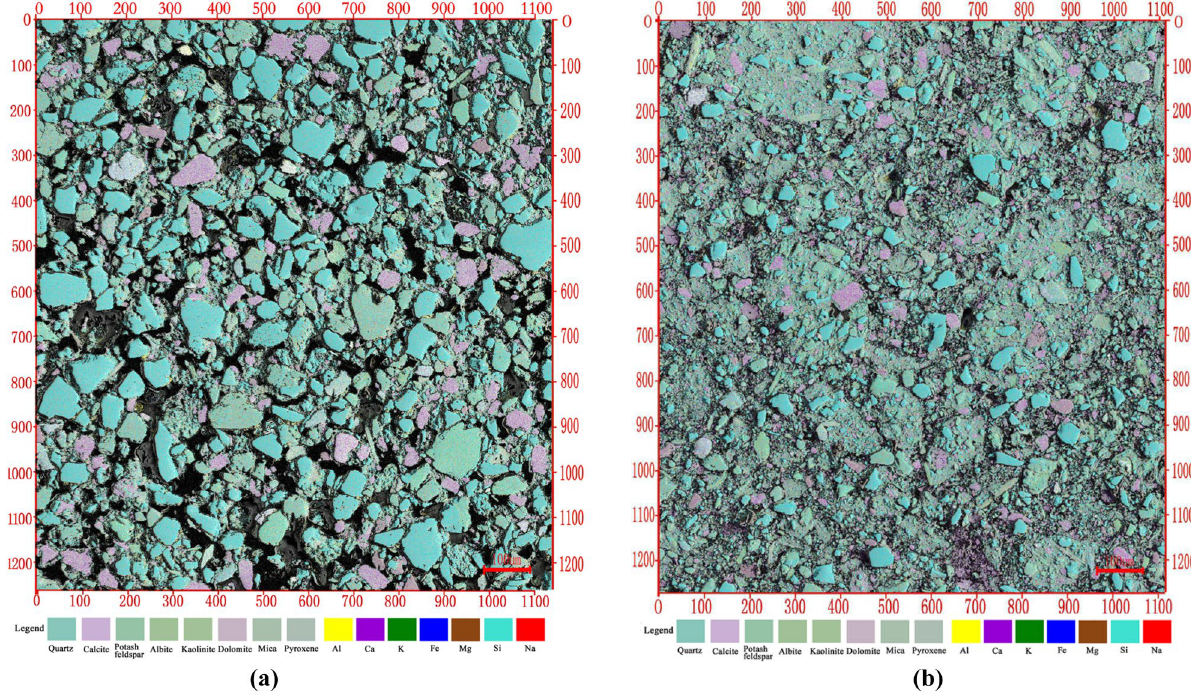
Figure 7. Multi-scale microstructure of untreated loess and lime-treated loess from Xining: ( a ) untreated loess; ( b ) lime-treated loess.